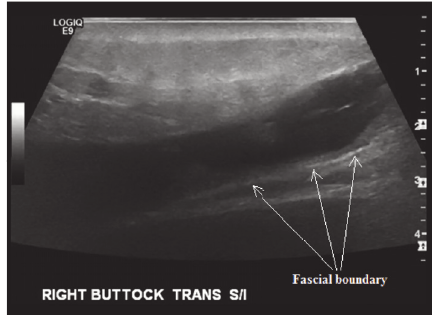
Figure 1: Sagittal ultrasound view of lesion. Note irregular borders and echogenic fat globules. Figure 2: Transverse ultrasound view of lesion. Note fluid collection bounded by fascial